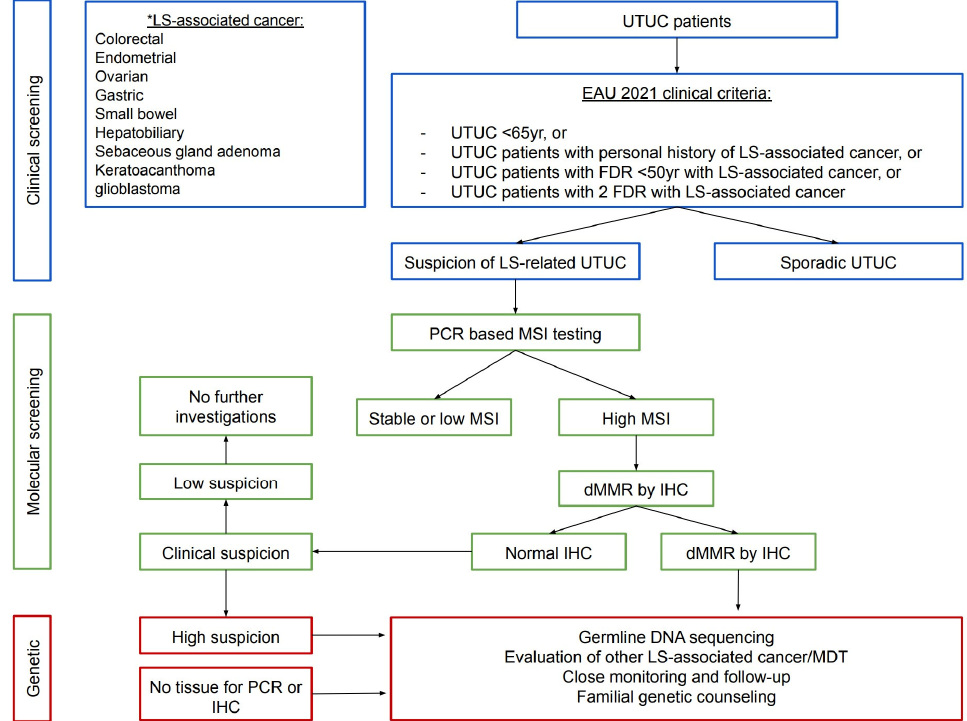
Figure 4. Flow chart for diagnosis of Lynch syndrome in individuals with upper tract urothelial carcinoma. Adapted from the European Association of Urology—Young Academic Urologists and Global Society of Rare Genitourinary Tumours [28]. * LS ‐ associated cancer.